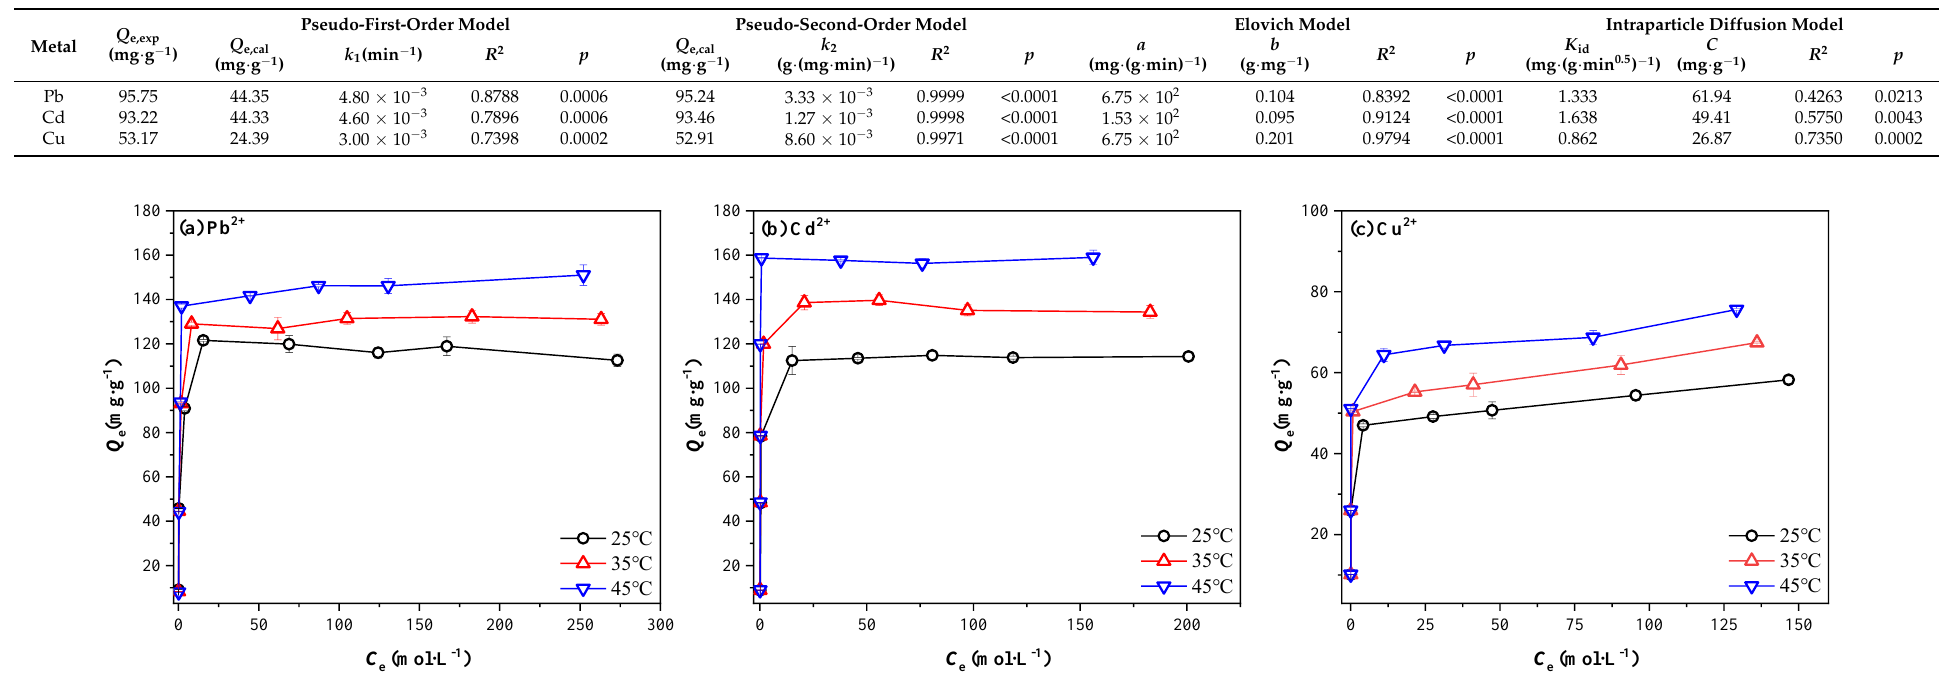
Figure 5. The adsorption curves of Cd 2+ , Pb 2+ and Cu 2+ onto MSCB-2 at different temperatures. Table 3. Adsorption isotherm parameters of heavy metals onto MSBC-2 at different temperatures for Langmuir and Freundlich models.